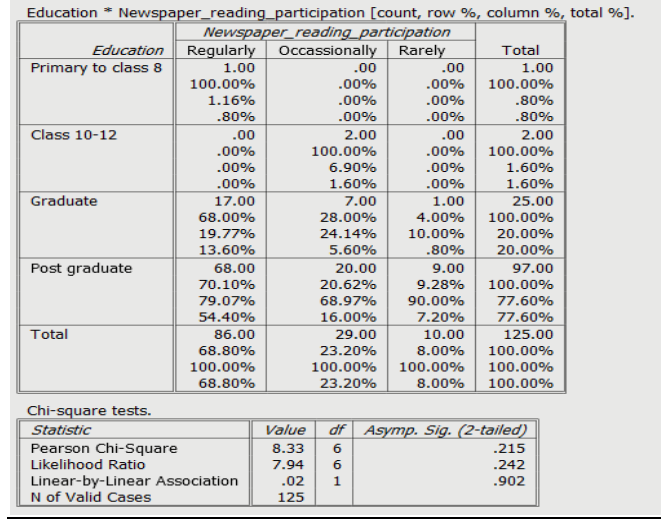
Figure 7: Cross tabulation and Chi-square between Education v/s Newspaper Reading Participation (Source: Authors‟ depiction)